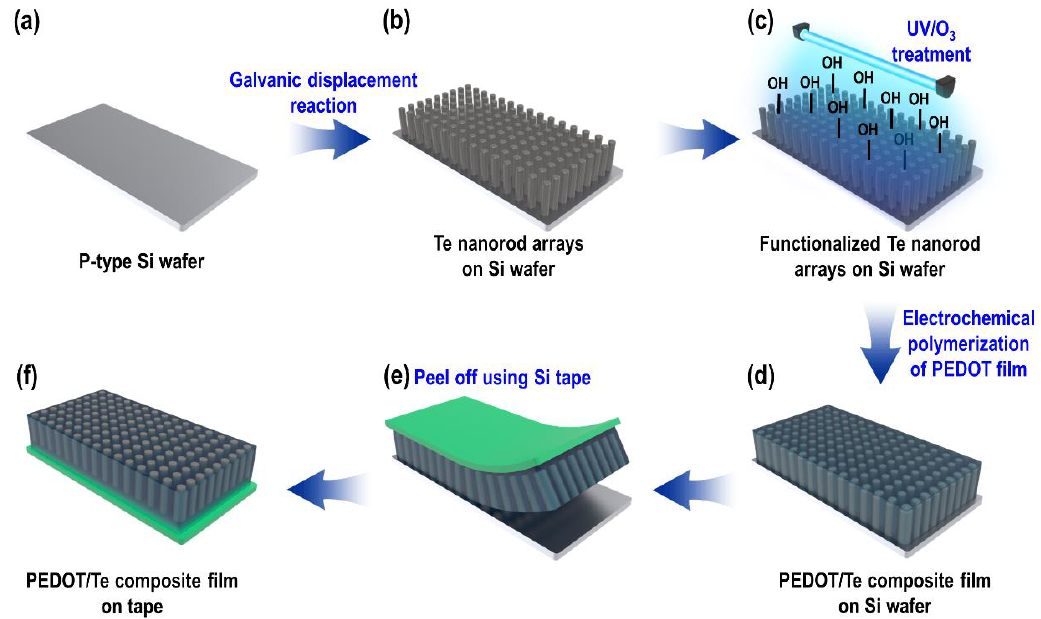
Figure 1. Schematic illustration of poly(3,4-ethylenedioxythiophene) (PEDOT)/Te composite film preparation.